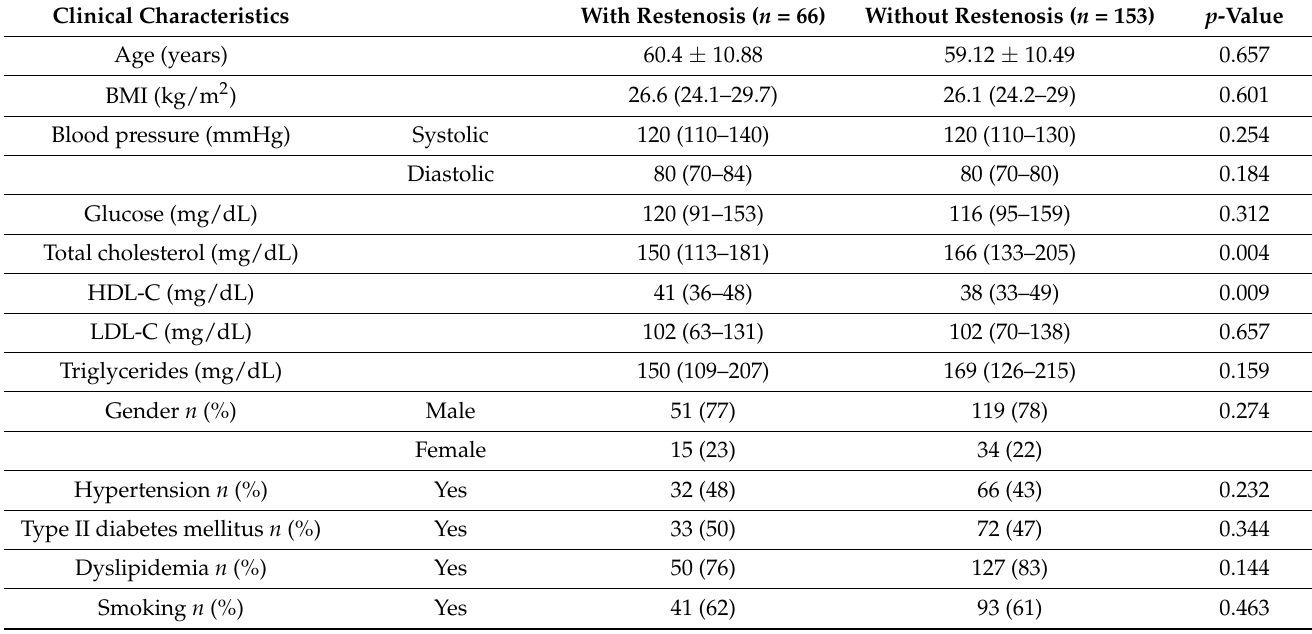
Table 2. Baseline clinical and angiographic characteristics of the CAD patients (patients with and without